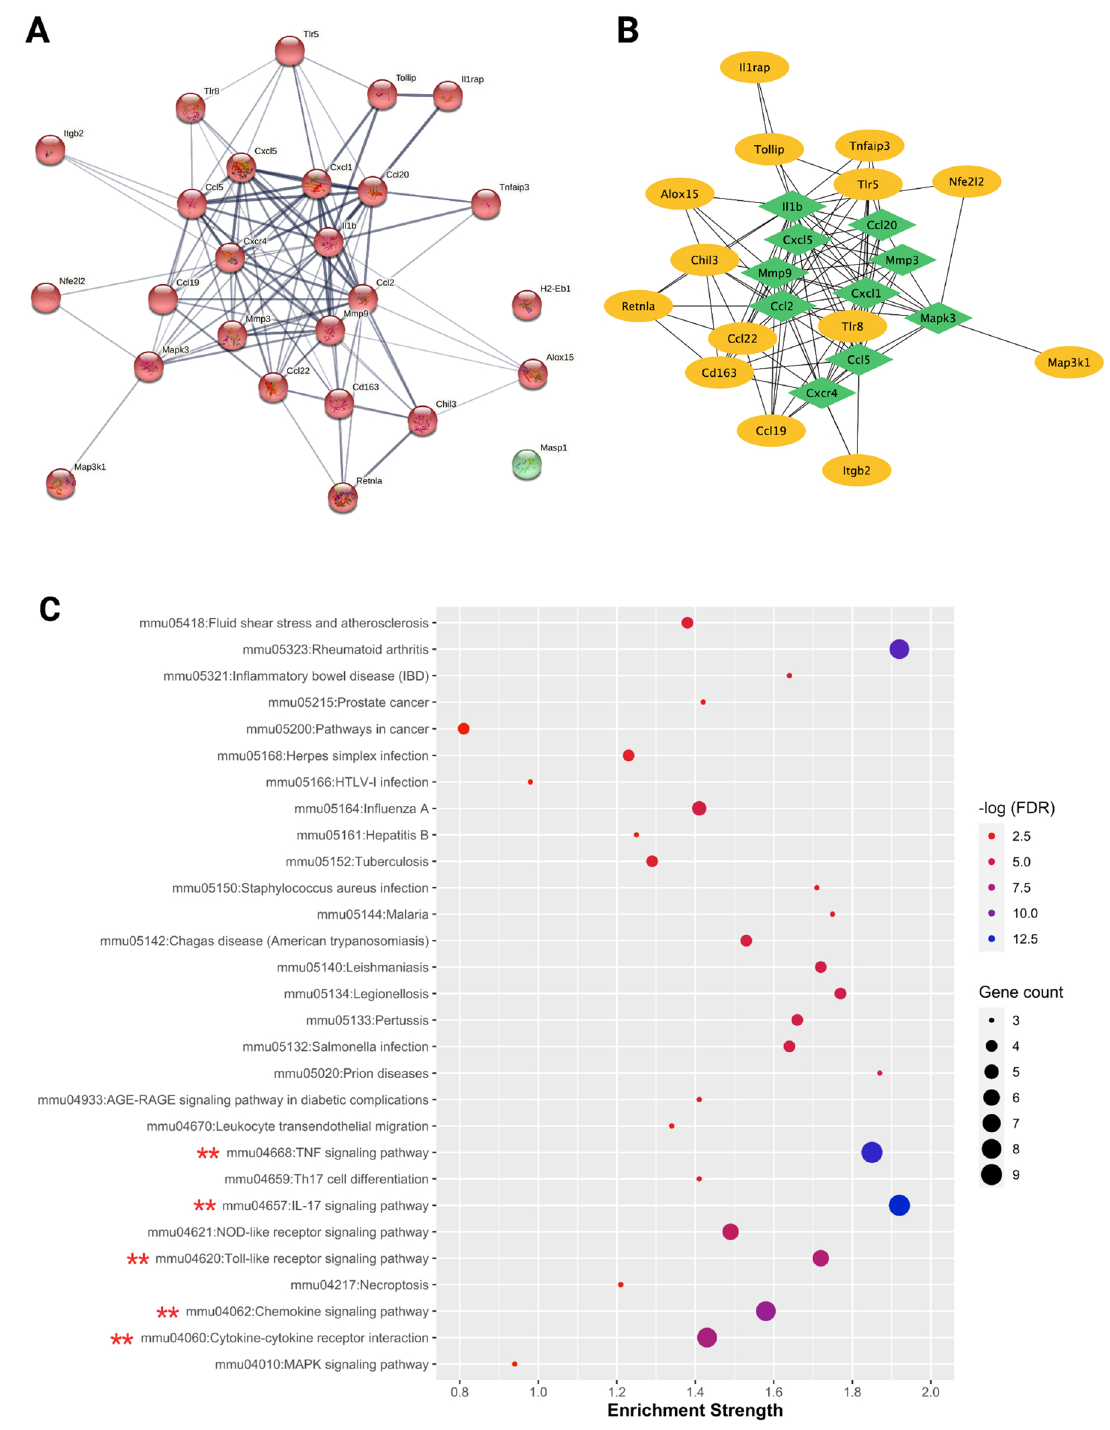
Figure 2. StringDB PPI network analysis and KEGG pathway enrichment. Medium confidence clustered (red) protein–protein interaction network (PPI) was built for HD group DEGs using StringDB ( A ). The Maximal Clique Centrality (MCC) algorithm present in the cytoHubba plugin of the Cytoscape software was used for PPI hub gene identification. MMP9, Cxcl1, Cxcl5, Cxcr4, IL-1β, MMP3, Ccl2, Ccl20, Ccl5, and Mapk3 were the top 10 hub genes identified as indicated by the green diamond-shaped boxes ( B ). KEGG pathway-based enrichment analysis 25–28 of the StringDB PPI revealed 29 significantly enriched pathways, with the top 5 inflammation- associated pathways as indicated by double, red-colored asterisks ( C